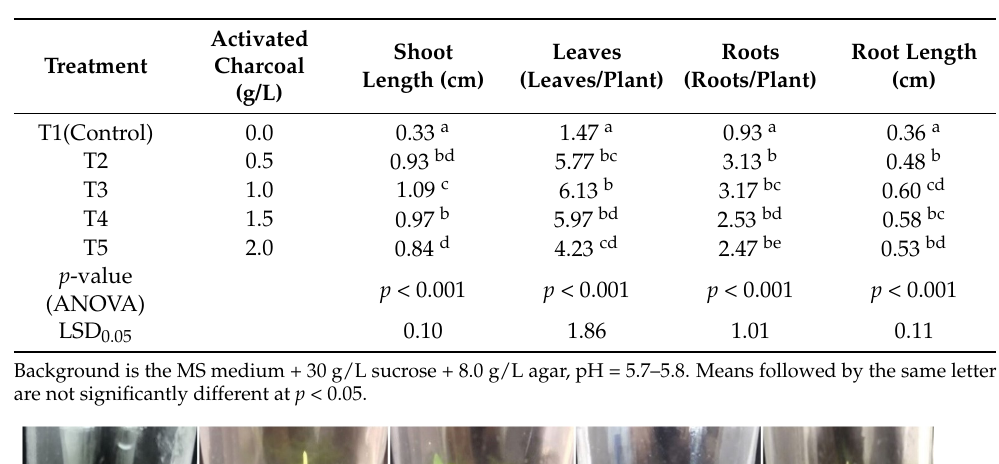
Table 8. Effect of activated charcoal on the growth and development of D. anosmum Lindl. (6 weeks after culturing).